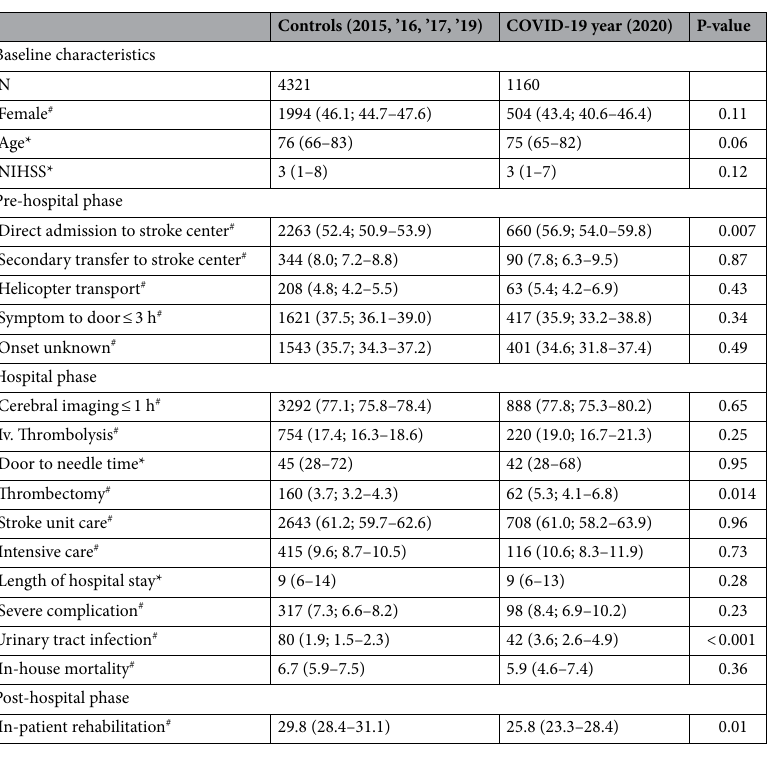
Table 1. Differences between patient characteristics and pre-/intra-hospital- and post-hospital-stroke care metrics comparing pre-COVID-19 years and 2020. # Values given as N (%; 95% CI). *Values given as median (IQR). Severe complications composite variable: infections (pneumonia, sepsis), myocardial infarction, recurrent or progressive stroke, intracranial- or extracranial bleeding, epileptic seizure and deep vein thrombosis or pulmonary embolism. Cerebral imaging ≤ 1 h: cerebral imaging (CT/MRI) within 1 h after hospital